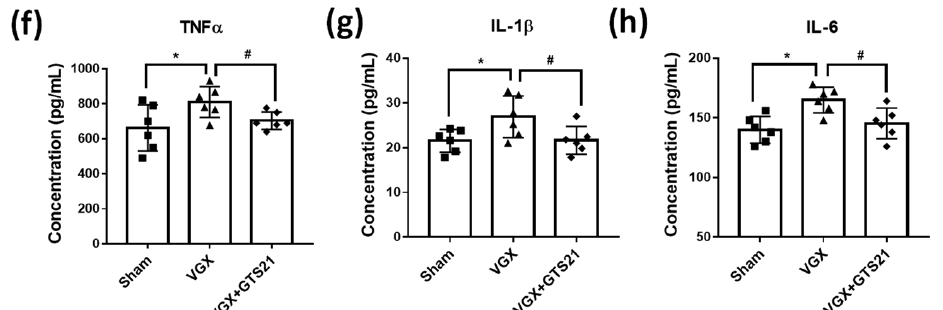
Figure 1. Effects of CAP activity on the development of atherosclerotic plaque and inflammation level in Apoe -/- mice. ( a ) The Apoe -/- mice were subjected to three experimental groups, i.e., sham, bilateral cervical vagotomy surgery (VGX) alone, and VGX supplemented with GTS-21 (VGX + GTS-21). The three groups of mice were fed with a high-fat diet for 10 weeks and then used for analysis. ( b ) Oil-red-O (ORO) staining of en face preparations of the thoracic aorta. Representative samples are shown. Scale bars represent 200 mm. ( c ) Quantitative analysis of the atherosclerotic plaque area in the aorta. Data are presented as means ± SD ( n = 5 mice). * p < 0.05 as compared to sham; # p < 0.05 as compared to VGX; ns indicates not significant. ( d ) The aortic arch was sectioned and stained with ORO. Representative samples are shown. Scale bar represents 100 μ m. ( e ) Quantitative analysis of the atherosclerotic lipid lesion in the aortic root. (Average of 3–5 sections per mouse). Data are presented as mean ± SD ( n = 18–20 sections). * p < 0.05 as compared to sham; # p < 0.05 as compared to VGX; ns indicates not significant. ( f – h ) Serum levels of TNF α ( f ), IL-1 β (g), and IL-6 ( h ) in each group of experimental animals. Data are presented as mean ± SD ( n = 6 mice). * p < 0.05 as compared to sham; # p < 0.05 as compared to VGX; ns indicates not significant.